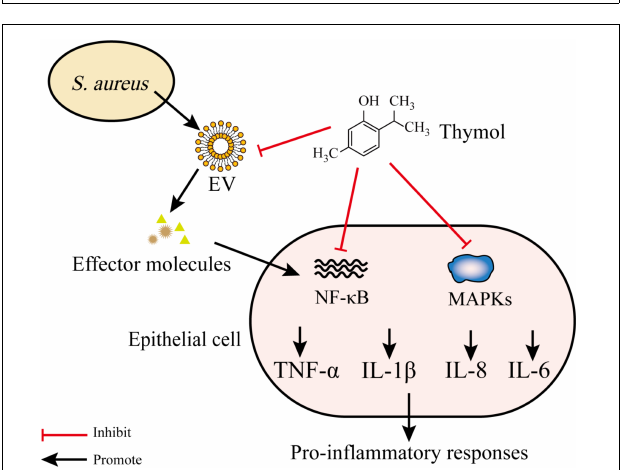
FIGURE 4 | Thymol disrupts EVs and inhibits NF- κ B and MAPKs pathways. S. aureus EVs contain various effector molecules which trigger NF- κ B and MAPKs and lead to the release of proinflammatory cytokines. Thymol reduce proinflammatory cytokines production by inhibiting effector molecules transfer to host and inhibiting NF- κ B and MAPKs